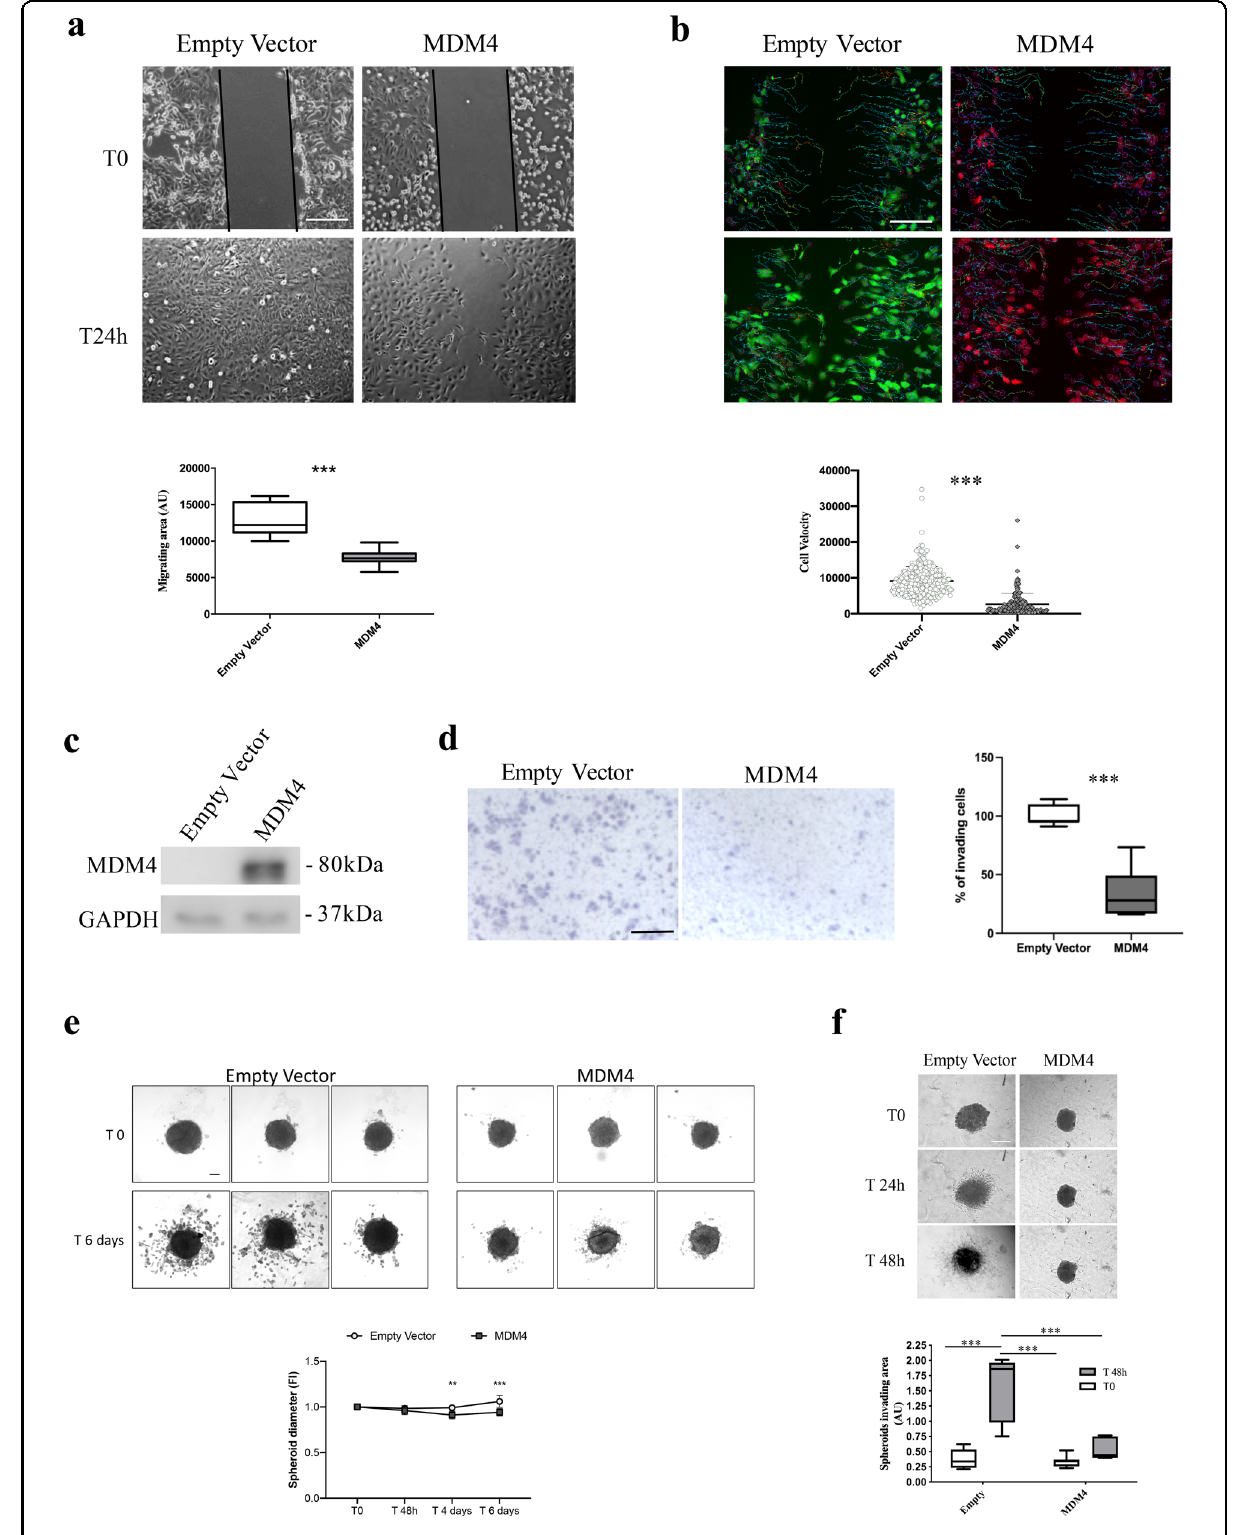
Fig. 2 (See legend on next